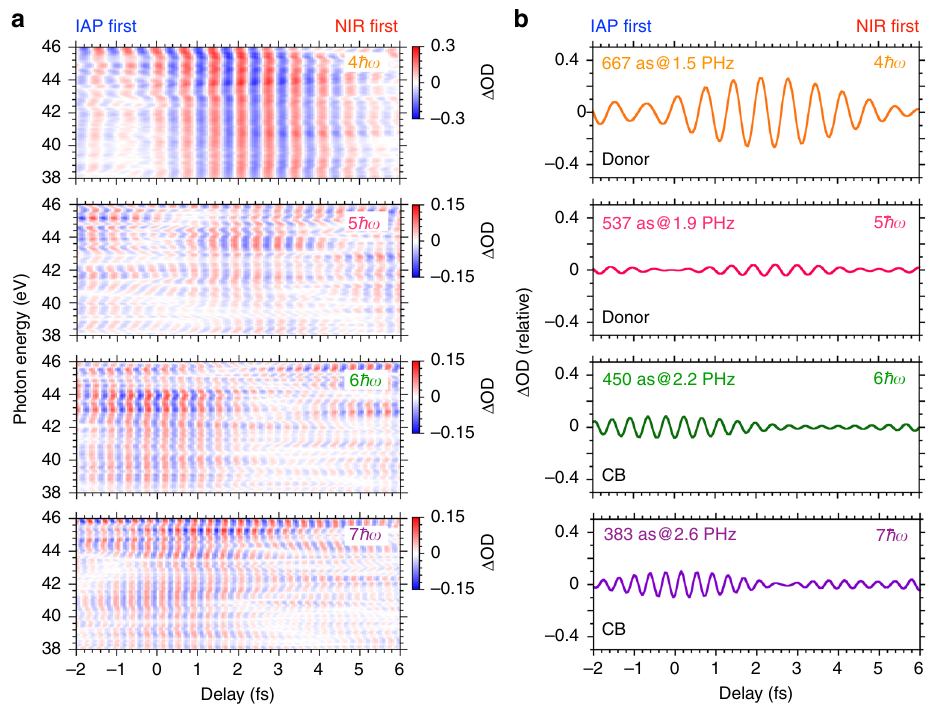
Fig. 3 Temporal structure of each energy component. a Temporal structures in Fig. 2a after windowed Fourier transform. The window energies of Fourier fi ltering are 6.2 (4 ħ ω ), 7.7 (5 ħ ω ), 9.2 (6 ħ ω ), and 10.8 eV (7 ħ ω ). The applied window energy width is ±0.35 eV, taking into account the NIR bandwidth. The 4 ħ ω and 5 ħ ω correspond to the donor-like state. The 6 ħ ω and 7 ħ ω correspond to the CB state. b Traces showing the integrated line pro fi le for the photon energy regions of 38 – 46 eV in a . The electric dipole oscillations with periodicities of 667 (4 ħ ω ), 537 (5 ħ ω ), 450 (6 ħ ω ), and 383 as (7 ħ ω ) correspond to frequencies of 1.5, 1.9, 2.2, and 2.6 PHz, respectively